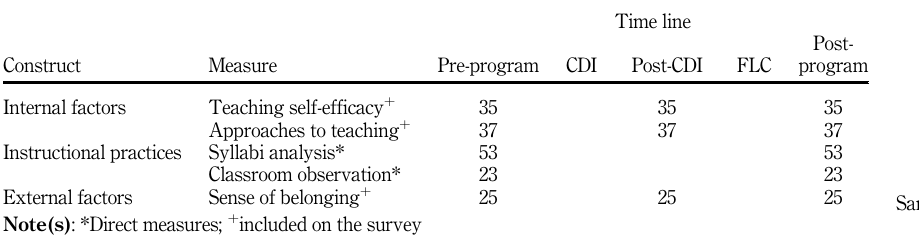
Table 2. Sample sizes for